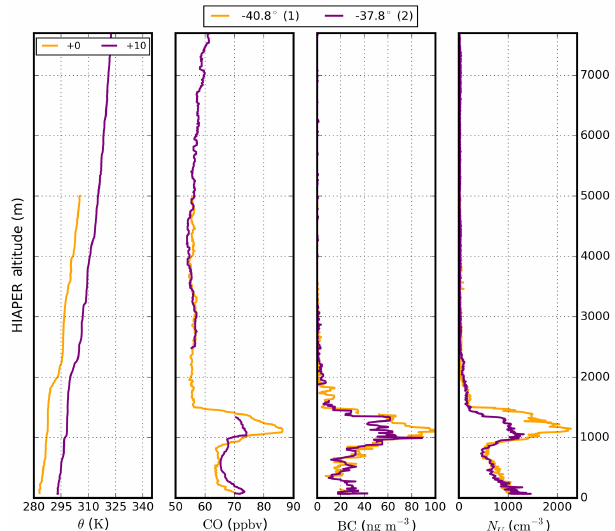
Figure 10. As for Fig. 9, but for RF07, showing a clear example of a polluted plume over the Bass Straight to the south of Melbourne. Note different x scales for CO, BC, and N U compared to Fig.